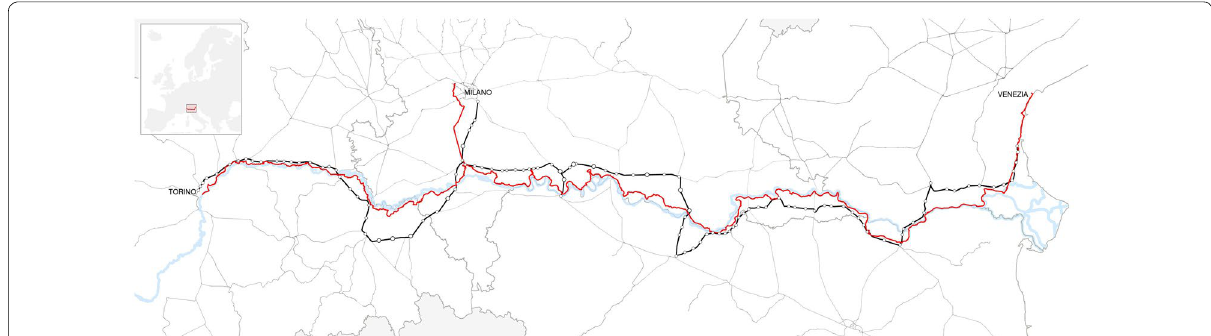
Fig. 1 The cycle tourist backbone VENTO (red), along the Po river (light blue), and railway line (black) and stations in its proximity (white points). [Scale